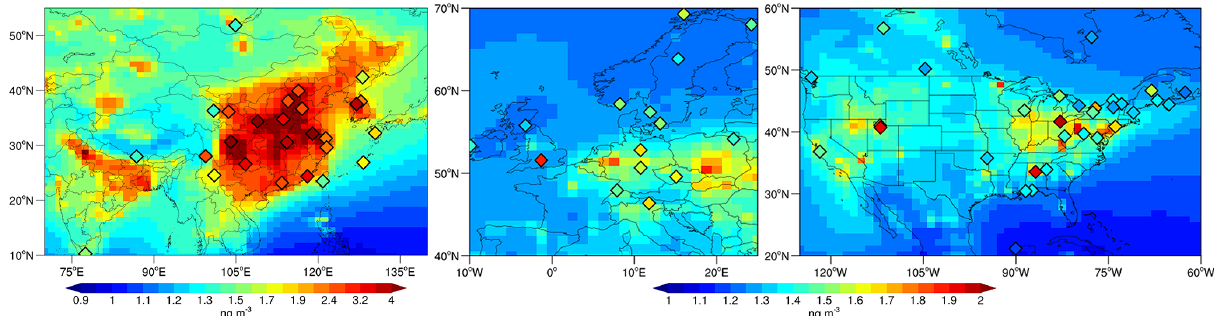
Figure 5. Regional distribution of surface TGM concentrations in eastern Asia, western Europe, and North America. Ground-based obser- vations (rhombuses) are the same as Fig. 3. Note that two different color bars are used to depict regional